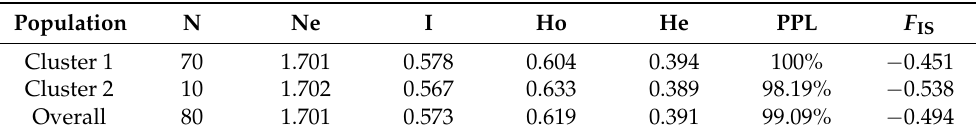
Figure 4. Distribution of ( A ) polymorphism information content (PIC), ( B ) genetic diversity, ( C ) minor allele frequency, and ( D ) percentage of heterozygosity for 2857 SNP markers among the 80 R. mucronata accessions. Table 5. Genetic diversity measurement of two populations of R. mucronata accessions used in this study based on 2857 SNP markers.